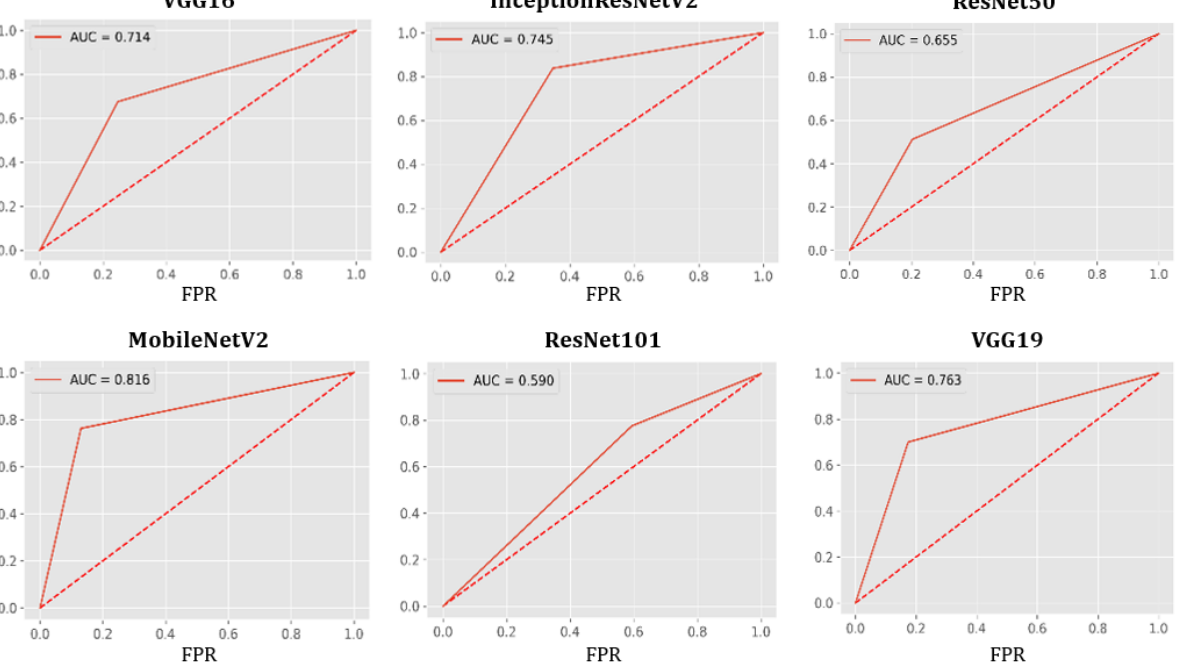
Figure 6. AUC-ROC curves for all models using the test